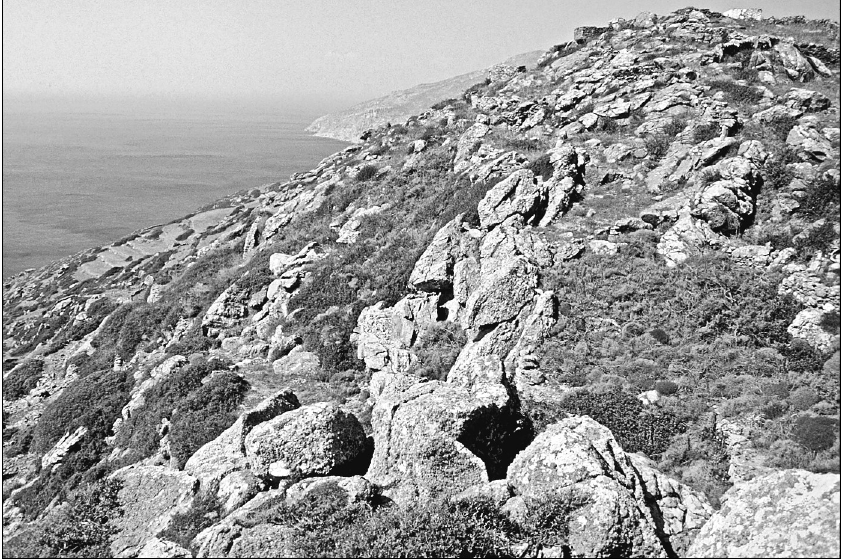
Figure 2 A view of the southern slope at Markiani, Amorgos, with (upper right) the site on the summit.